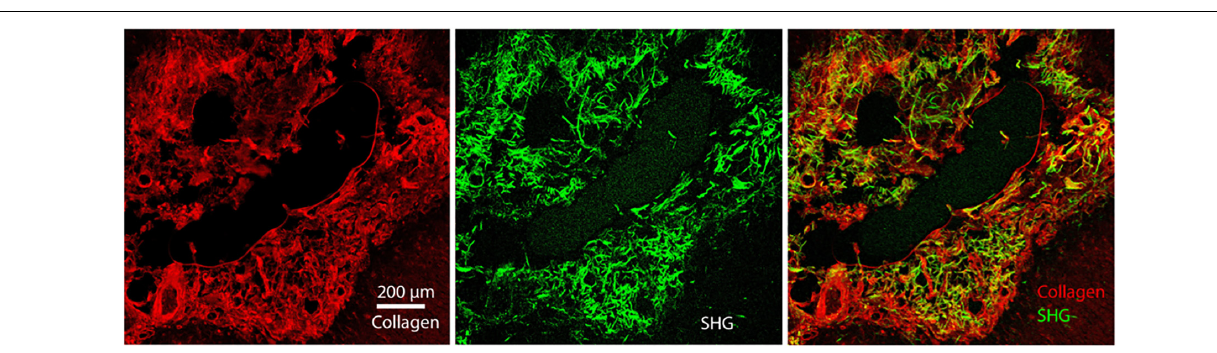
FIGURE 5 | Immunohistochemistry of Collagen I overlaid with GFAP of the astrocytic glial scar in chronic horizontal slices. We re-registered the two files with fine-structures registration (BUNWARPJ, FIJI). We used a mask from SHG to see if all the pixels are co-registered. We found 88% of the SHG pixels belong to the collagen 1 antibody staining. Scale bar = 200